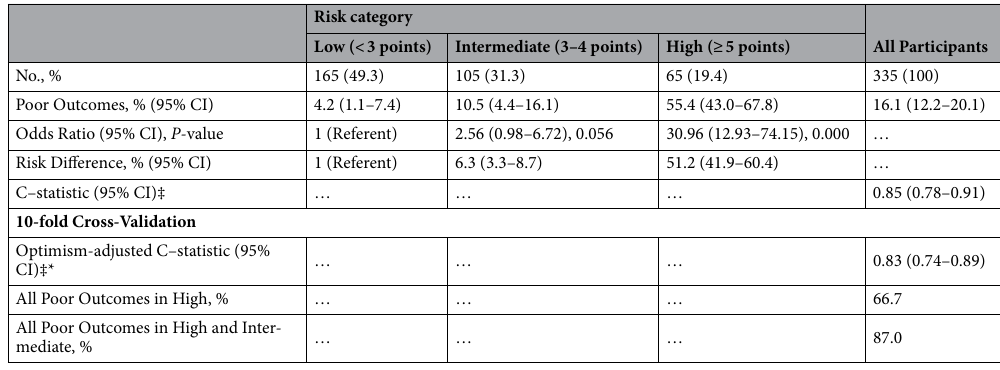
Table 3. Risk of poor outcomes among persons living with diabetes diagnosed with tuberculosis according to risk category. Risk Difference, this is the percent difference between the intermediate- and high-risk group versus the low-risk